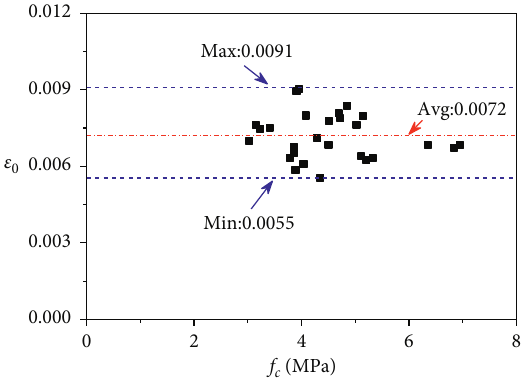
Figure 15: Peak strains of